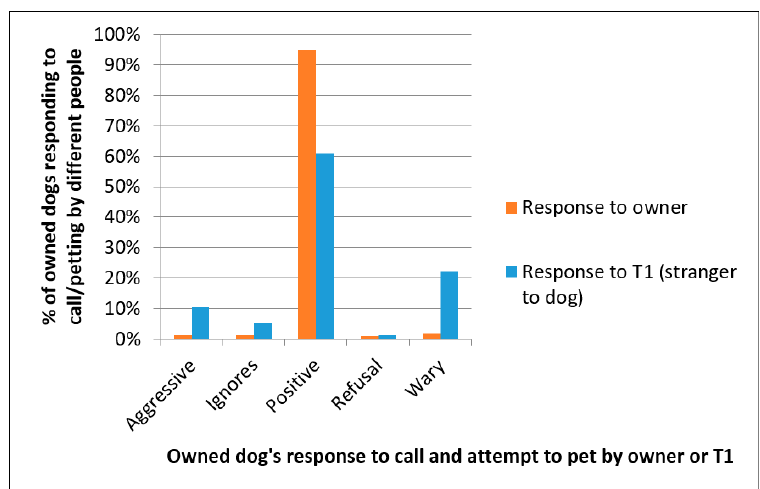
Figure 8. Responses of owned dogs to being called over and petted by owners and T1s.